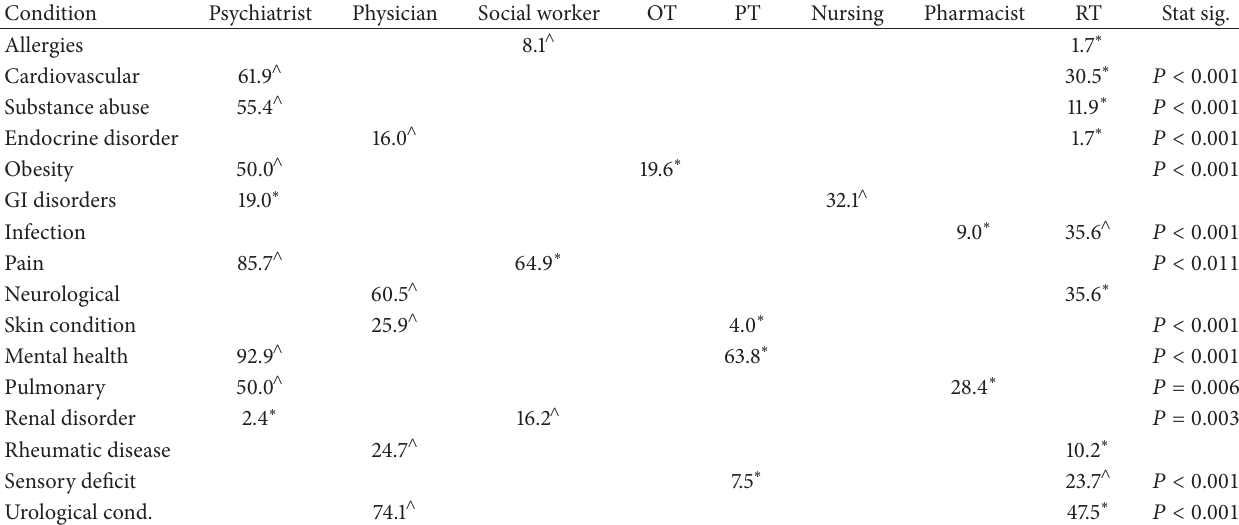
Table 3: Awareness of relationship between comorbidity and disordered sleep